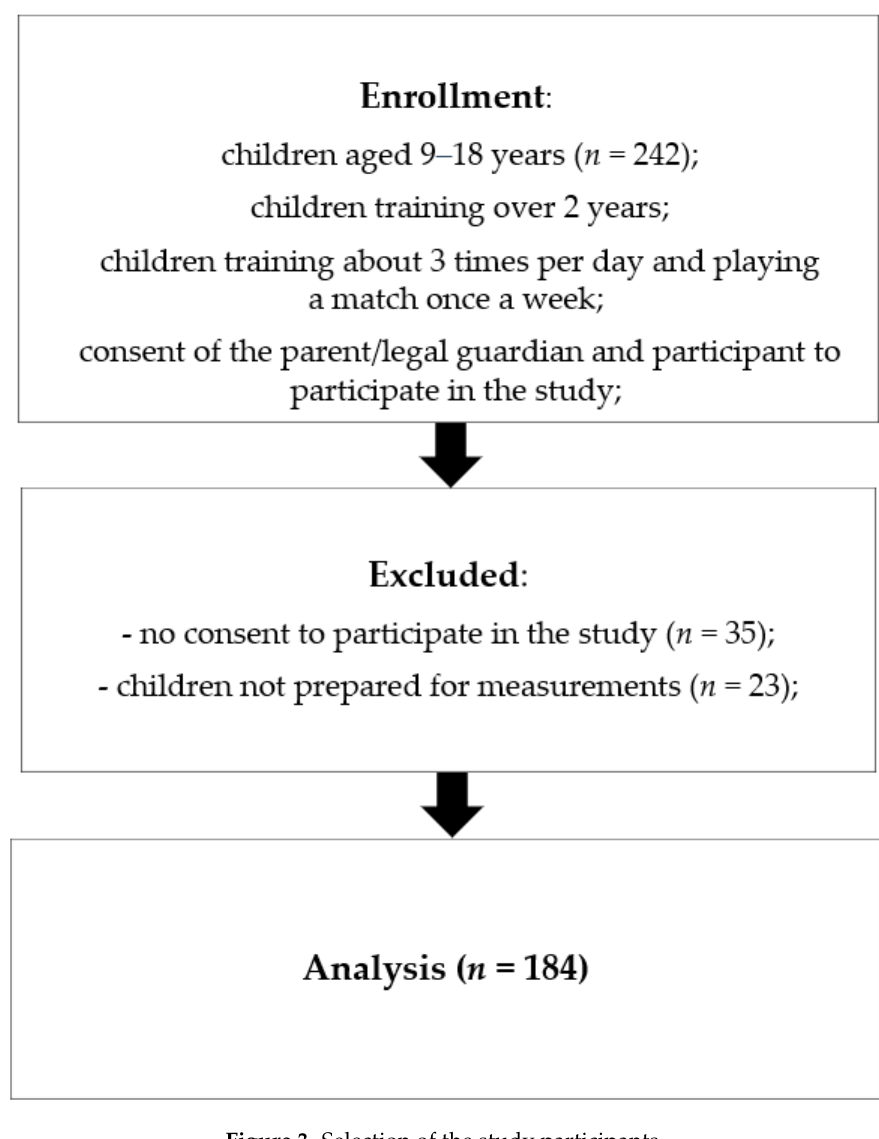
Figure 3. Selection of the study participants.